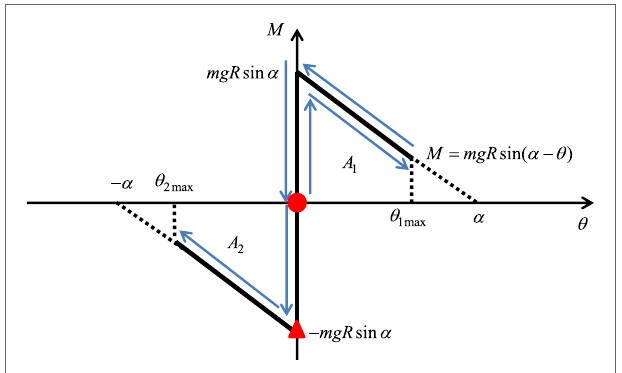
Figure 4 . From Eq. 6, once the velocity amplitude V of the double impulse is given, θ 1max can be